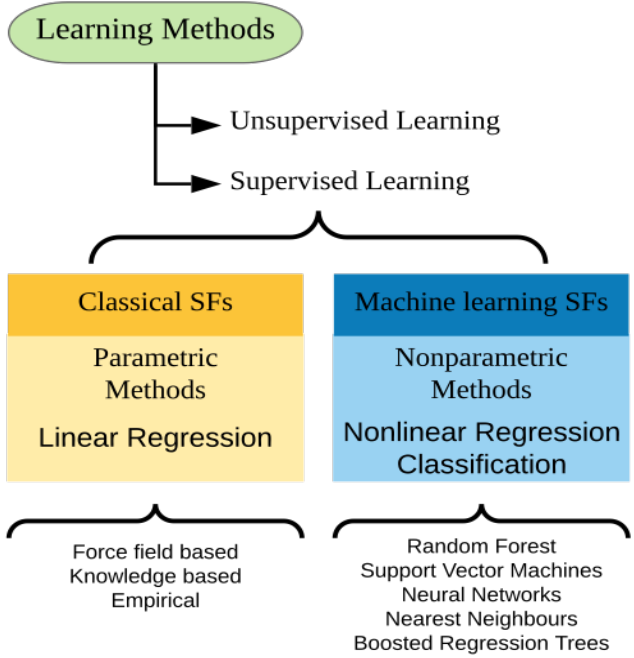
Figure 4. Learning methods can be broadly divided into supervised learning, when there is data available for training and parameterisation; and unsupervised learning, when there is no such data. Unsupervised learning cannot be used for binding affinity predictions and virtual screening. Supervised learning, on the other hand, can be divided into parametric and nonparametric learning. Parametric learning assumes a predetermined functional form, as observed in linear regression, and is the method employed in classical scoring functions. Nonparametric learning, or just machine learning, does not presume a predetermined functional form, which is instead inferred from the data itself. It can yield continuous output, as in nonlinear regression, or discrete output, for classification problems such as binders / nonbinders